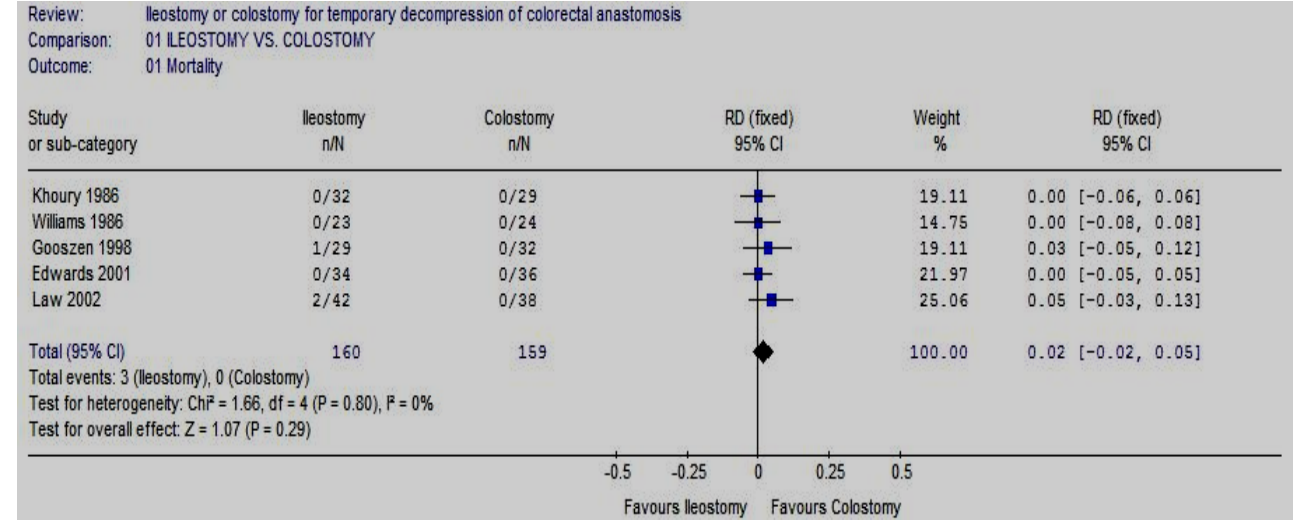
FIGURE 2 – Graph for the outcome of